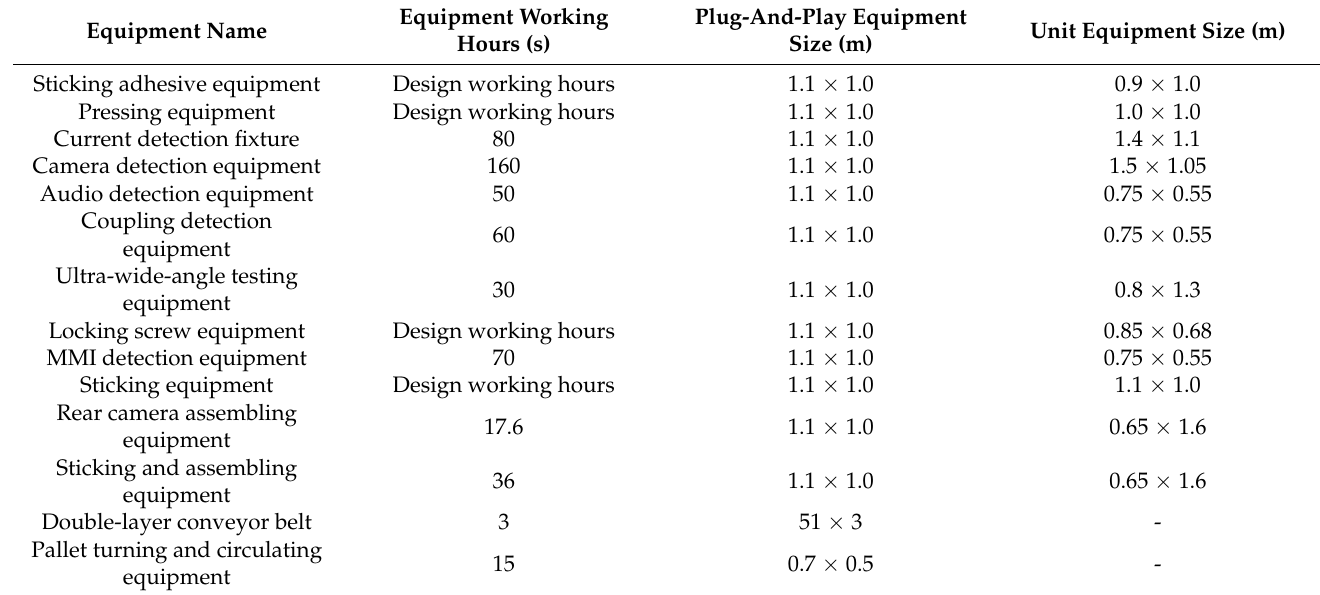
Table 2. List of